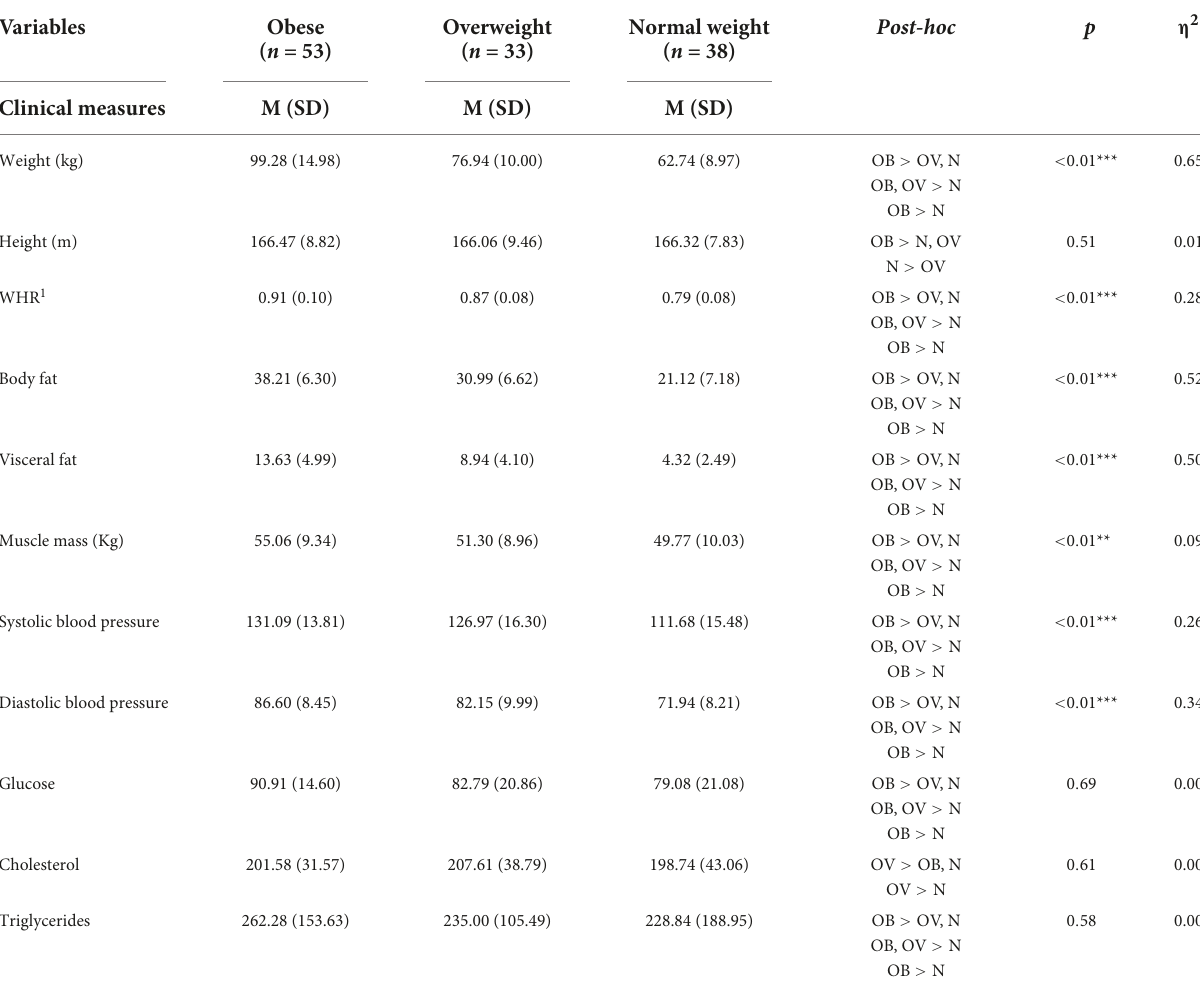
TABLE 3 Means and standard deviations in clinical and anthropometric